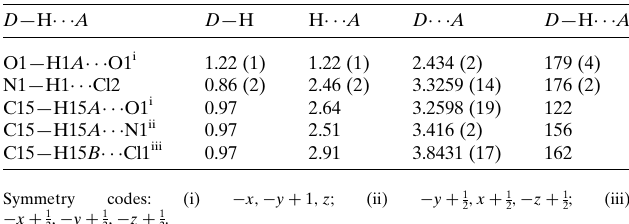
Table 2 Hydrogen-bond geometry (A˚ , (cid:3) ).